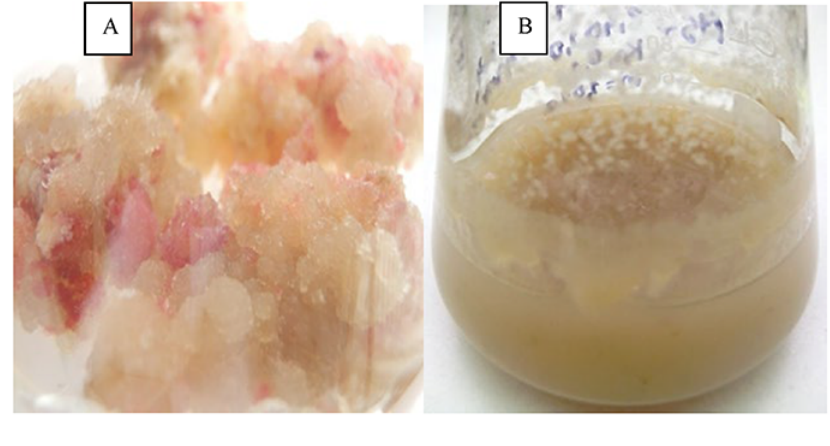
Figure 7 Chaenomeles japonica ( A ) callus and ( B ) cell suspension